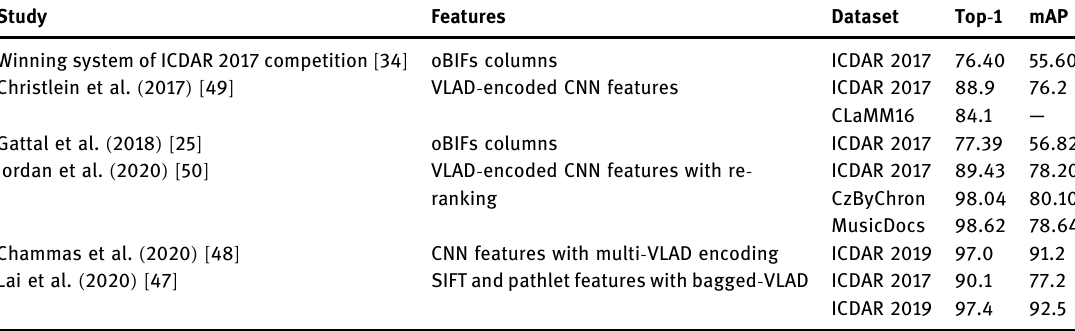
Table 1: An overview of notable writer identi fi cation studies evaluated on the ICDAR historical documents datasets